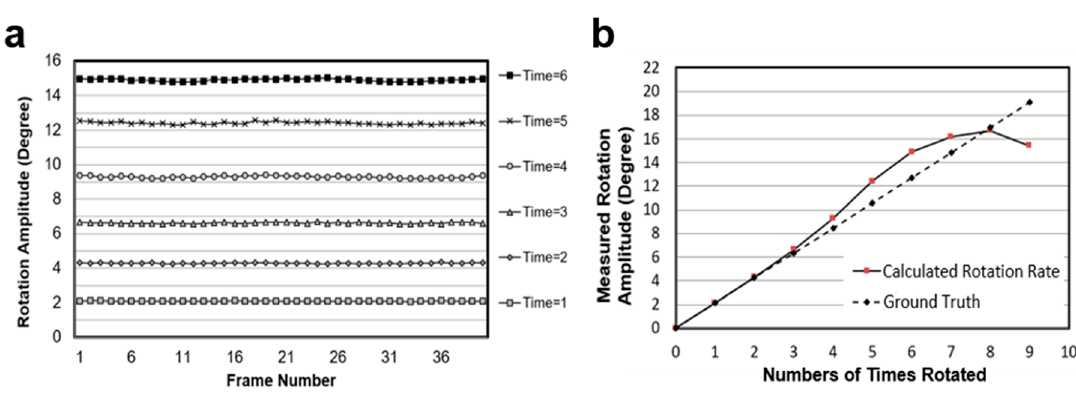
Figure 7. Evaluation of optical flow algorithm based Baker’s test template. ( a ) The rotation amplitude of the ball in different image sequences. In the legend, ‘ Time = n ’ represents how many times the rotation amplitude of the image sequence is that between two adjacent images, and n is the difference between the frame numbers; and ( b ) the comparison between the ground truth and the calculated rotation velocity on different testing sequences. The calculated rotation velocity is the average value of the same sequence.